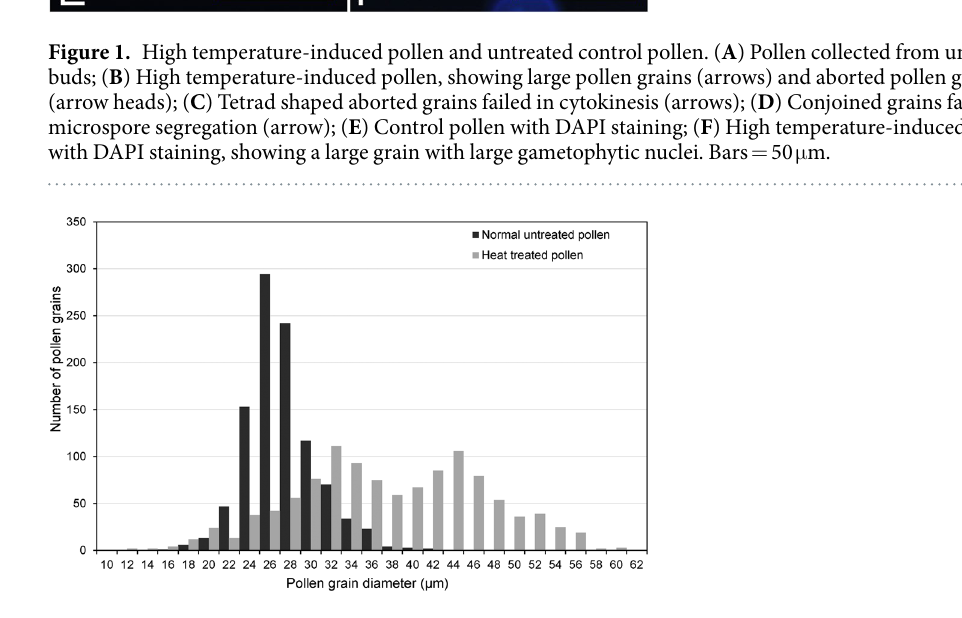
pollen development and allowed for more pollen to be produced compared to the 6-h treatment, indicating that a long exposure to heat tended to terminate development of microsporocytes. In the collected pollen samples, the frequencies of the high temperature-induced aborted grains, ranged from 49.27% to 91.01% for the different